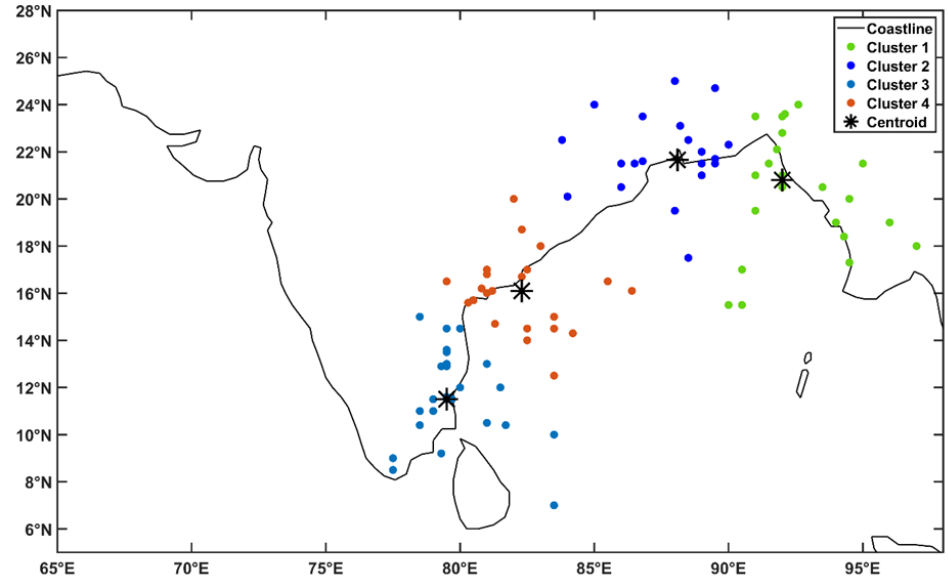
Figure 1. The tropical cyclone endpoint locations used for clustering classification (coloured dots) grouped by centroids of each cluster (represented by * ).